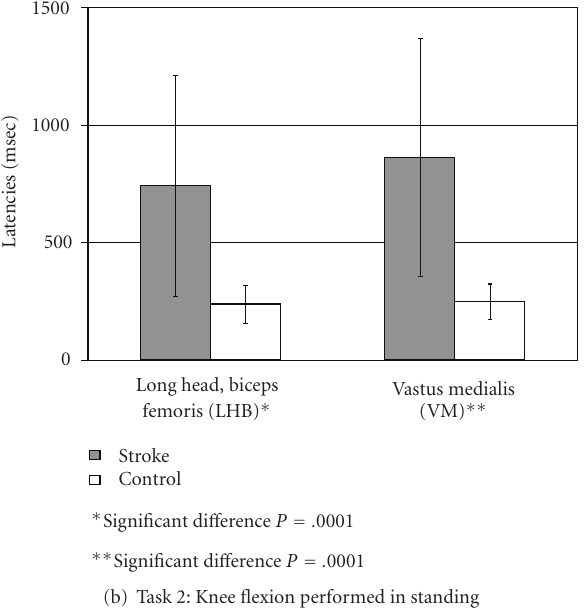
Figure 2: Comparison of onset latencies for control and stroke